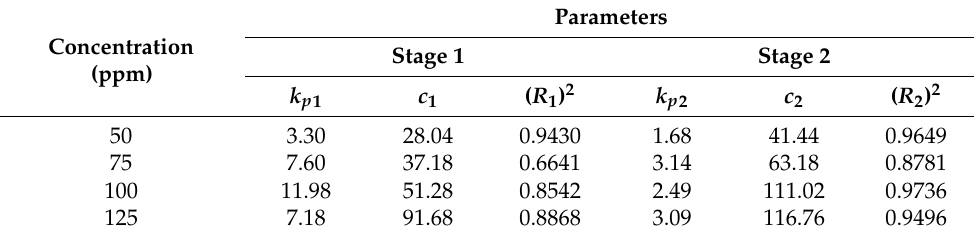
Table 4. Fitting parameters of intraparticle diffusion model of Cu 2+ adsorption.